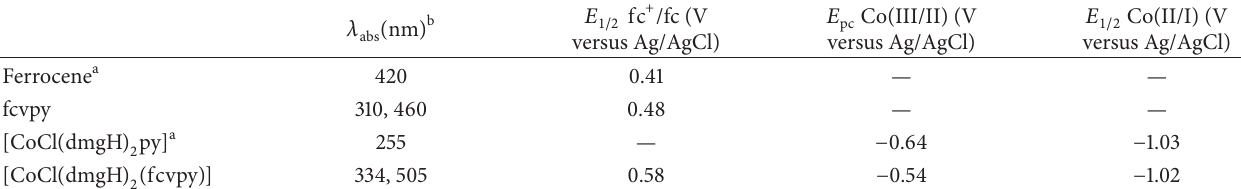
Table 1: Spectroscopic and electrochemical properties of 4-(2-ferrocenylvinyl)pyridine, fcvpy, and [ CoCl ( dmgH ) 2 ( fcvpy )] .